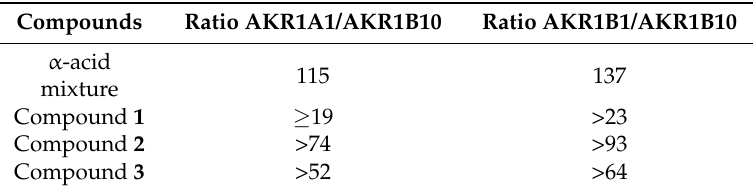
Table 3. AKR1B10 selectivity of the α -acid-mixture and its isolated compounds expressed as IC 50